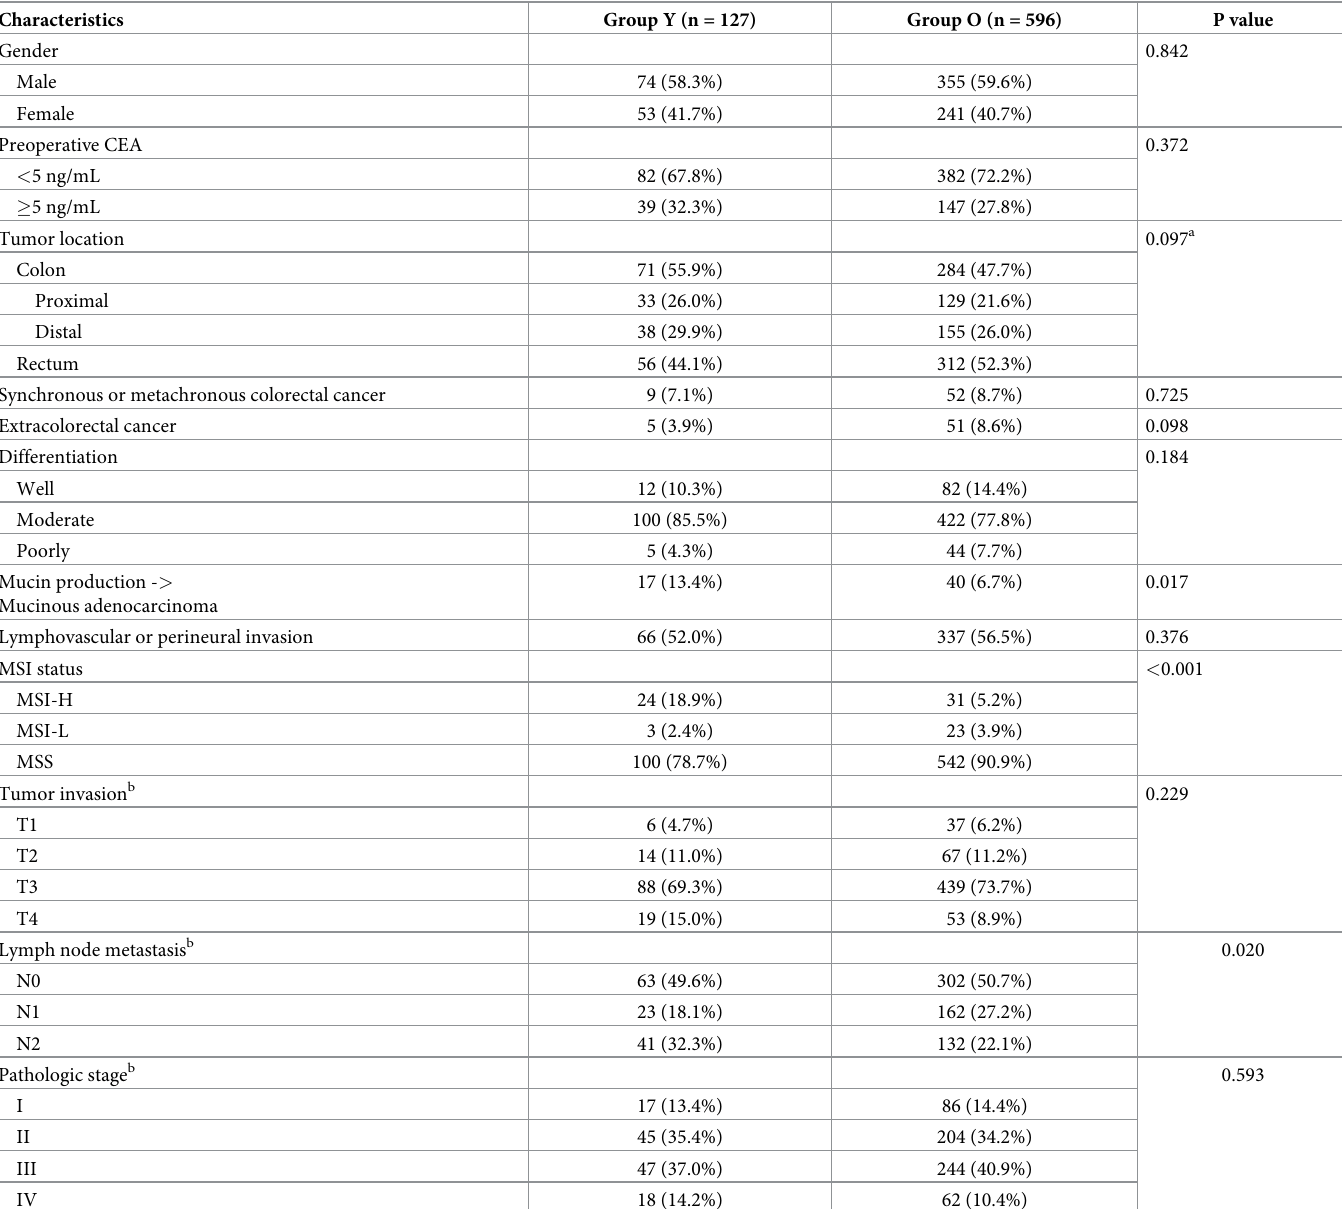
Table 1. Comparisons of the clinicopathological features between Groups Y and O with colorectal